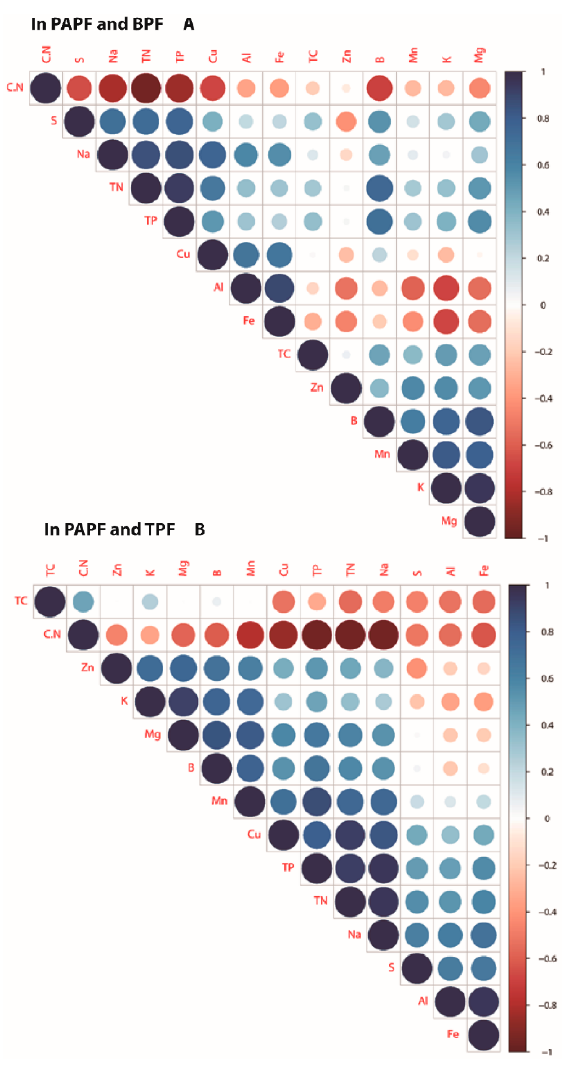
Figure 3. Pearson’s correlation of elemental compositions of coarse wood debris from the same dominant tree species ( Pinus koraiensis , PK) between in Picea koraiensis-Abies nephrolepis-Pinus koraiensis forest (PAPF), and in Tilia amurensis-Pinus koraiensis forest (TPF) ( A ) and between in Picea koraiensis- Abies nephrolepis-Pinus koraiensis forest (PAPF), and in Betula costata-Pinus koraiensis forest (BPF) ( B ) in Northeastern China. The significant positive (blue color) or negative (red color) correlations are indicated by colors and circle sizes. Abbreviations: TC: total carbon; C:N: carbon to nitrogen